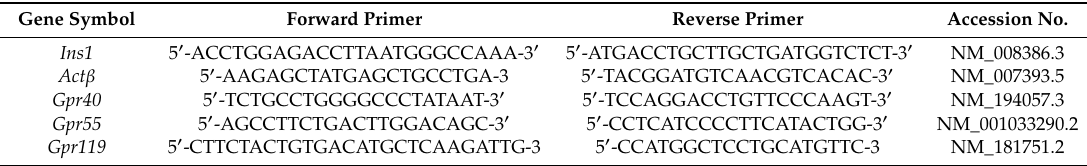
Table 1. Primers used in the